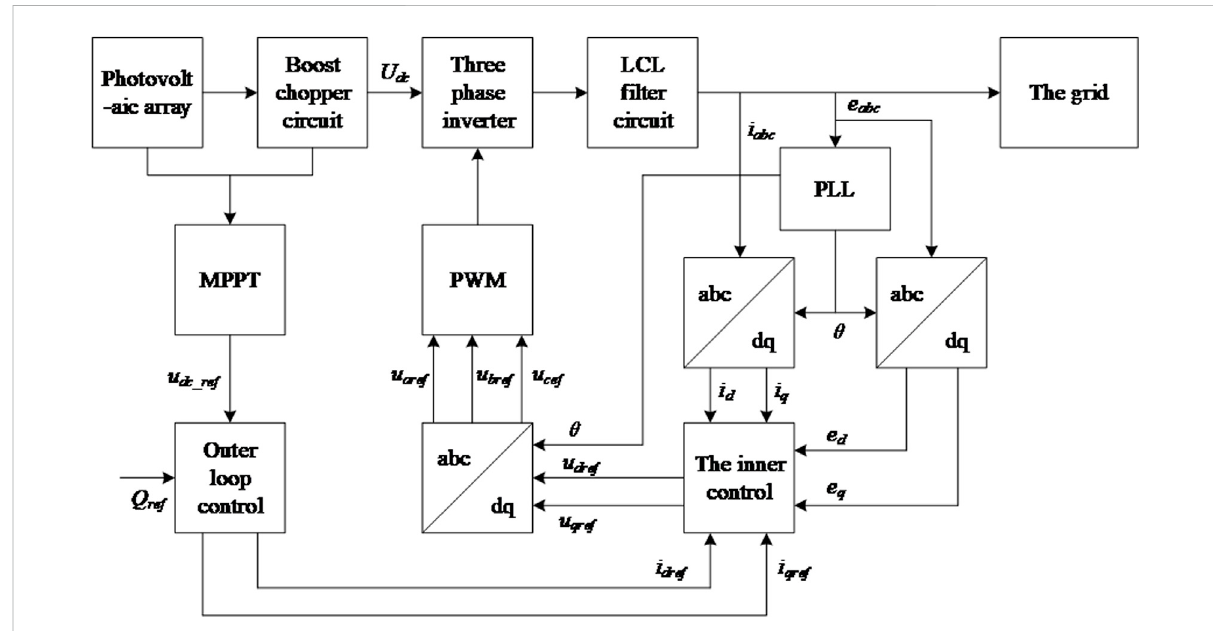
FIGURE 8 Schematic diagram of grid-connected operation control of distributed PV.